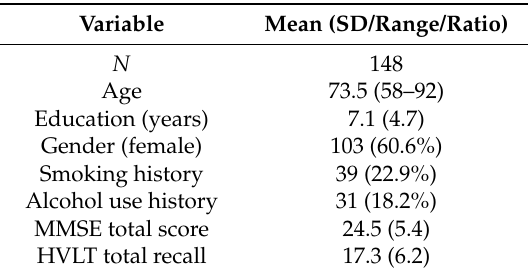
Table 1. Key demographics and cognitive test